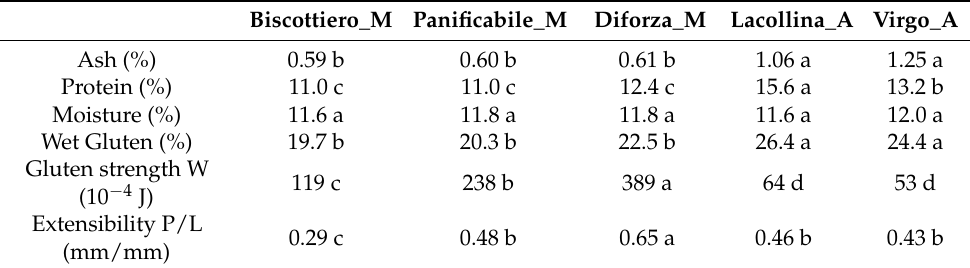
Table 1. Technical and alveograph gluten parameters in three commercially available modern wheat mixes (denoted by M) and two landrace wheat mixes (denoted by